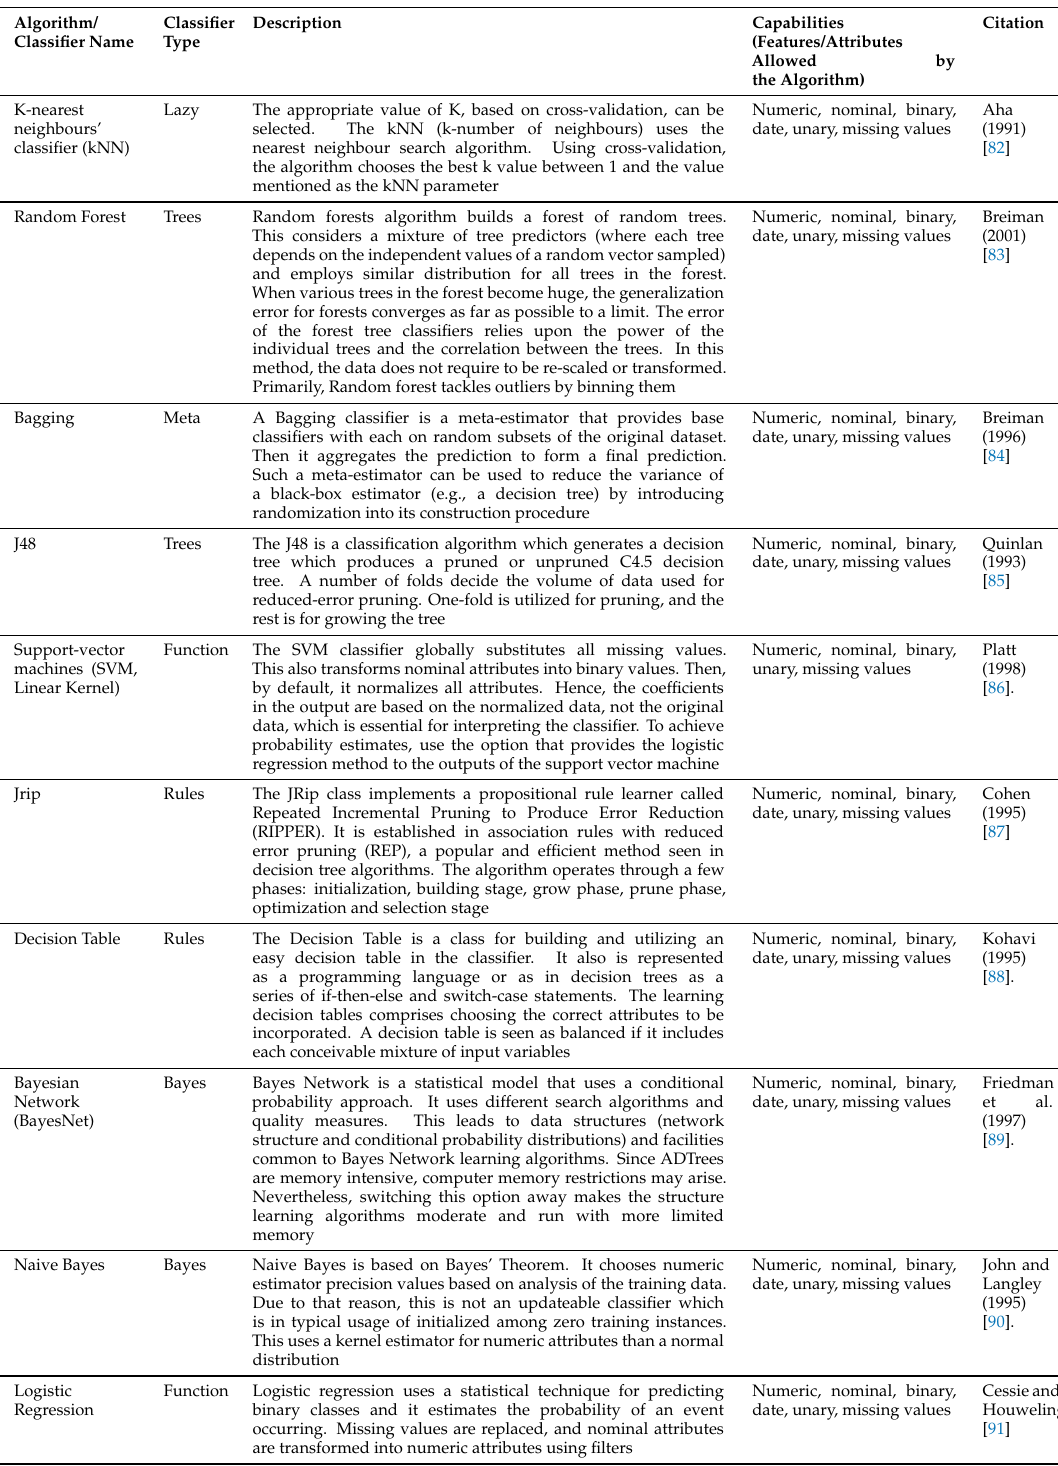
Table A1. Supervised machine learning or classification algorithms for the analysis were used to generate the